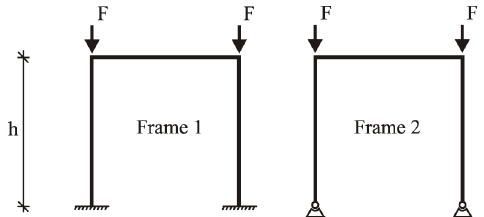
Fig. 2. Steel frame column end variants